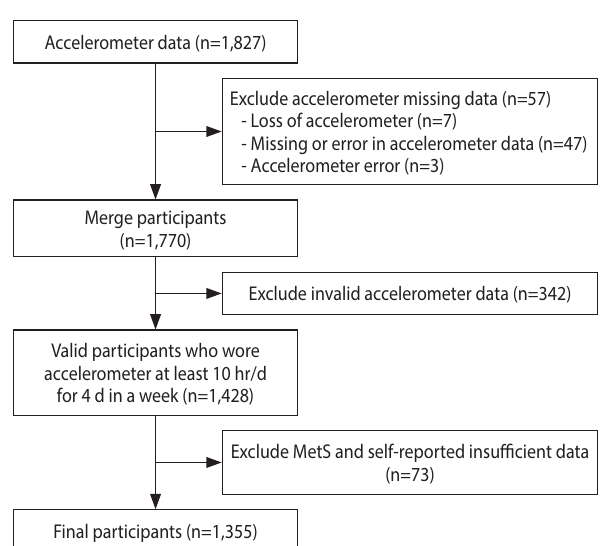
Figure 1. Flow diagram of study participant selection. MetS, meta- bolic